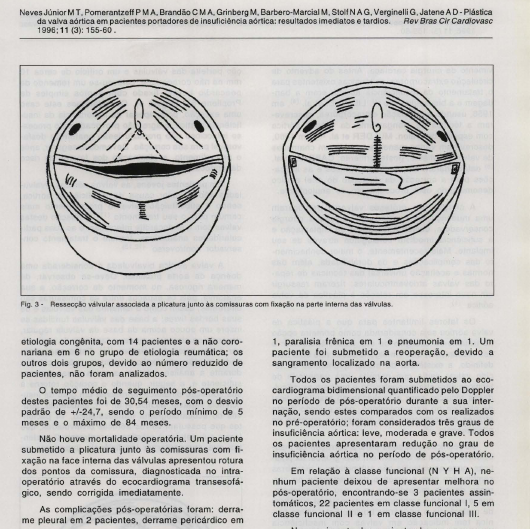
TABELAI PROCEDIMENTOS CIRt/RGlCOS ASSOCIADOS